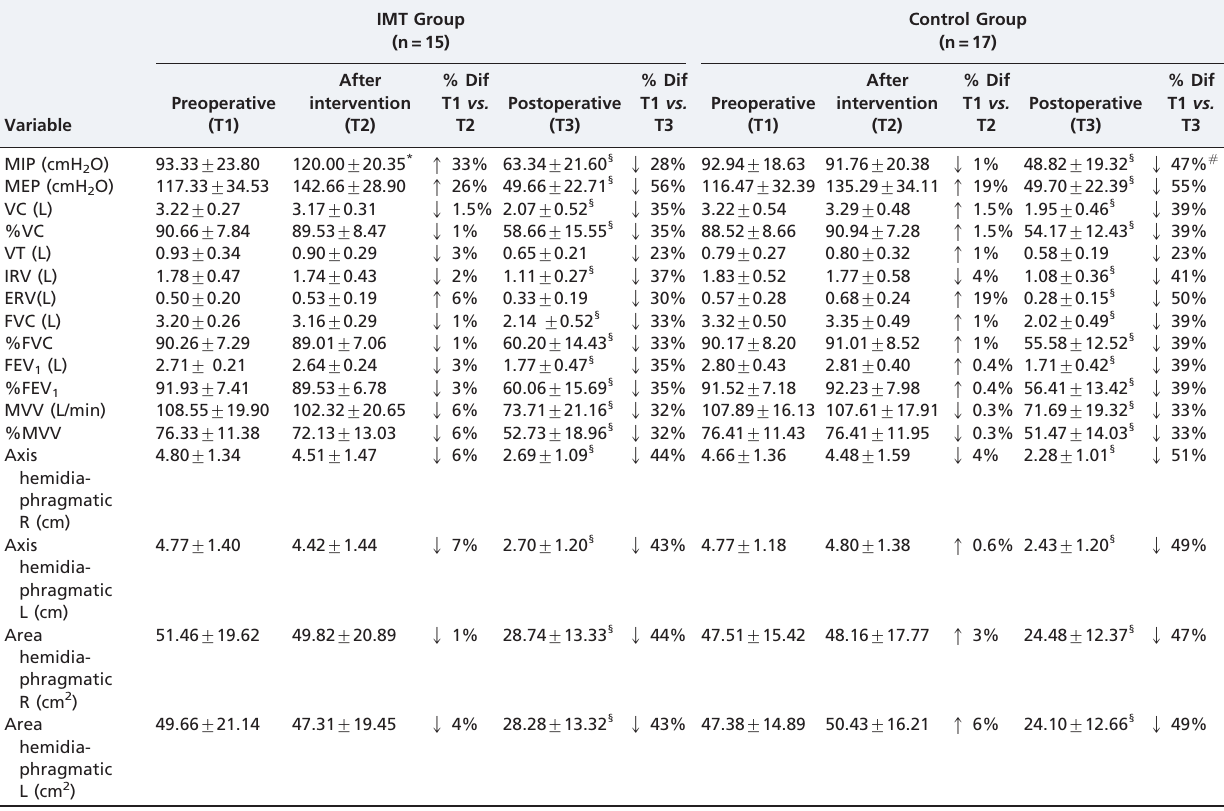
Table 3 - Respiratory muscle strength, lung volumes and diaphragmatic excursion in the IMT and Control groups (values expressed as mean and